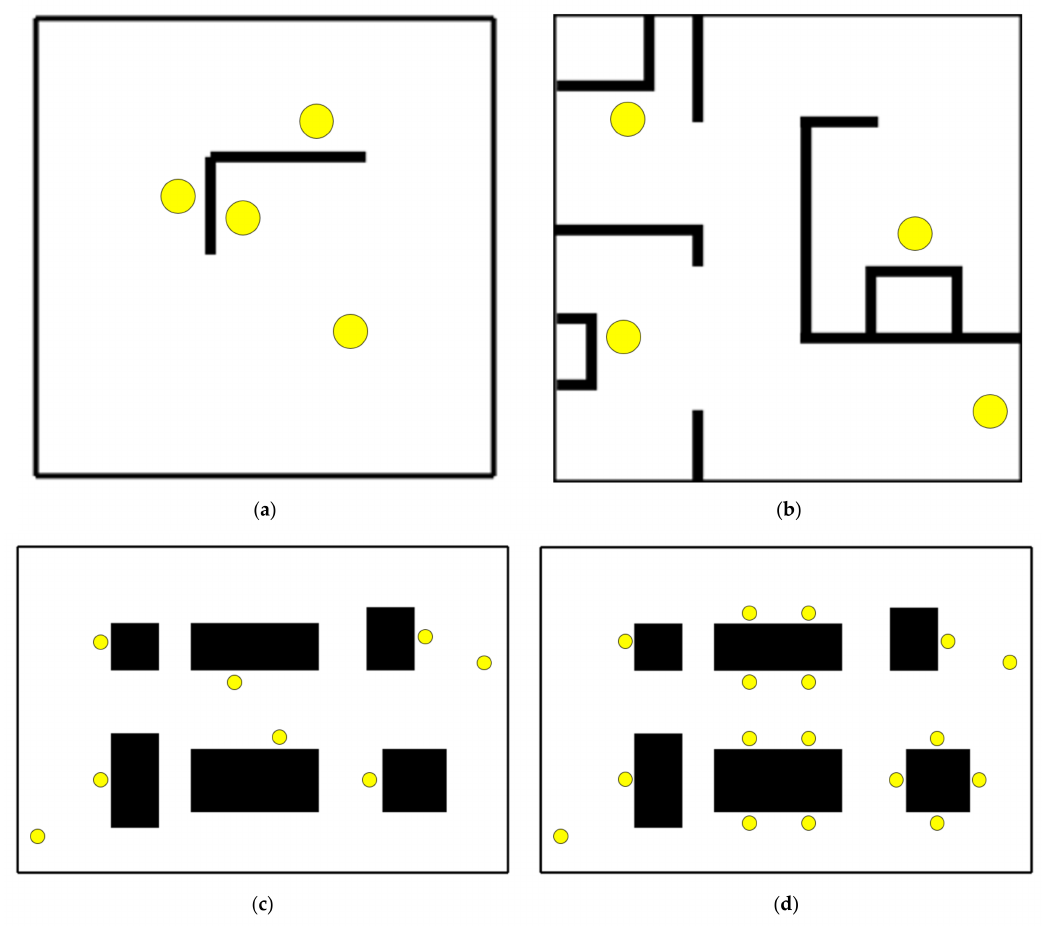
Figure 7. Other layouts: ( a ) four pick-up/drop-off locations, one wall, 12 × 12 m; ( b ) four pick-up/drop-off locations, multiple walls, 12 × 12 m; ( c ) eight pick-up/drop-off locations, 30 × 20 m; and ( d ) seventeen pick-up/drop-off locations, 30 × 20 m. Yellow circles are pick-up/drop-off locations, white represents the driving area, and black are the walls or other static